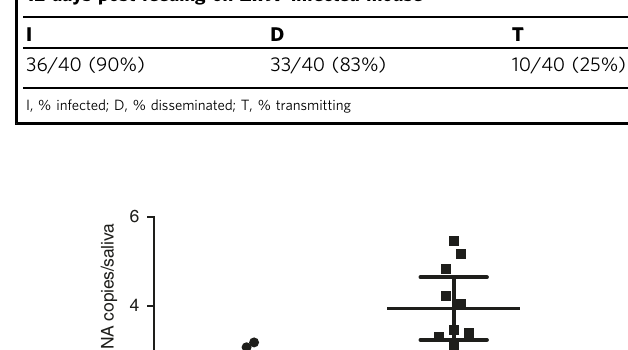
Table 1 Vector competence of Aedes aegypti used to challenge macaques with ZIKV